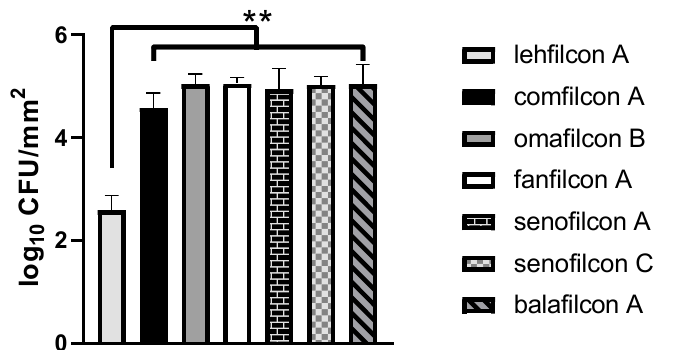
Figure 1. S. marcescens demonstrates low adhesion to lehfilcon A relative to other contact lens materials. Adhesion assays of S. marcescens MCC 7246 exposed to soft contact lenses ( n = 8 per lens material) in TSB medium containing 10% FBS as a soiling agent. The graph depicts the average log density of cells recovered after adhesion reactions (log CFU/mm 2 ± S.D.). ** indicates p < 0.0001 for comparison to lehfilcon